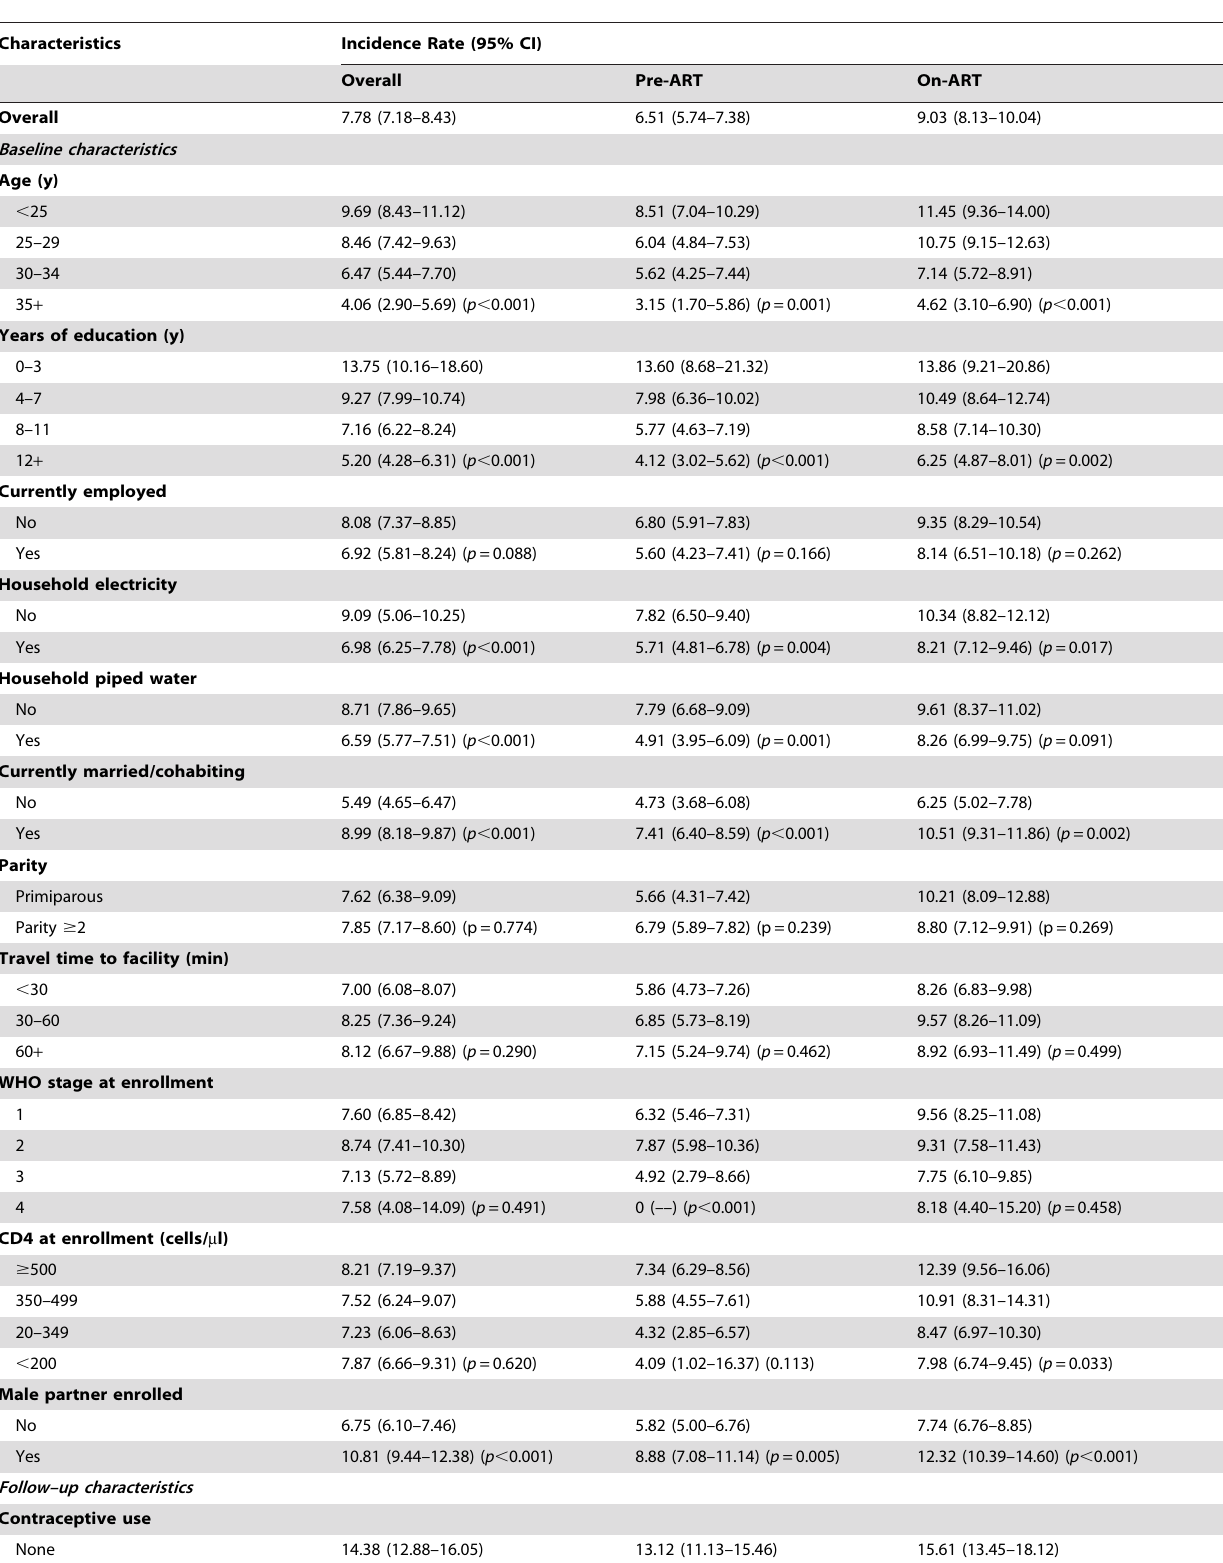
Table 2. Crude incidence rates of pregnancy per 100 person-years of observation, with 95% CIs, among women according to selected participant demographic, socioeconomic, clinical, and immunological